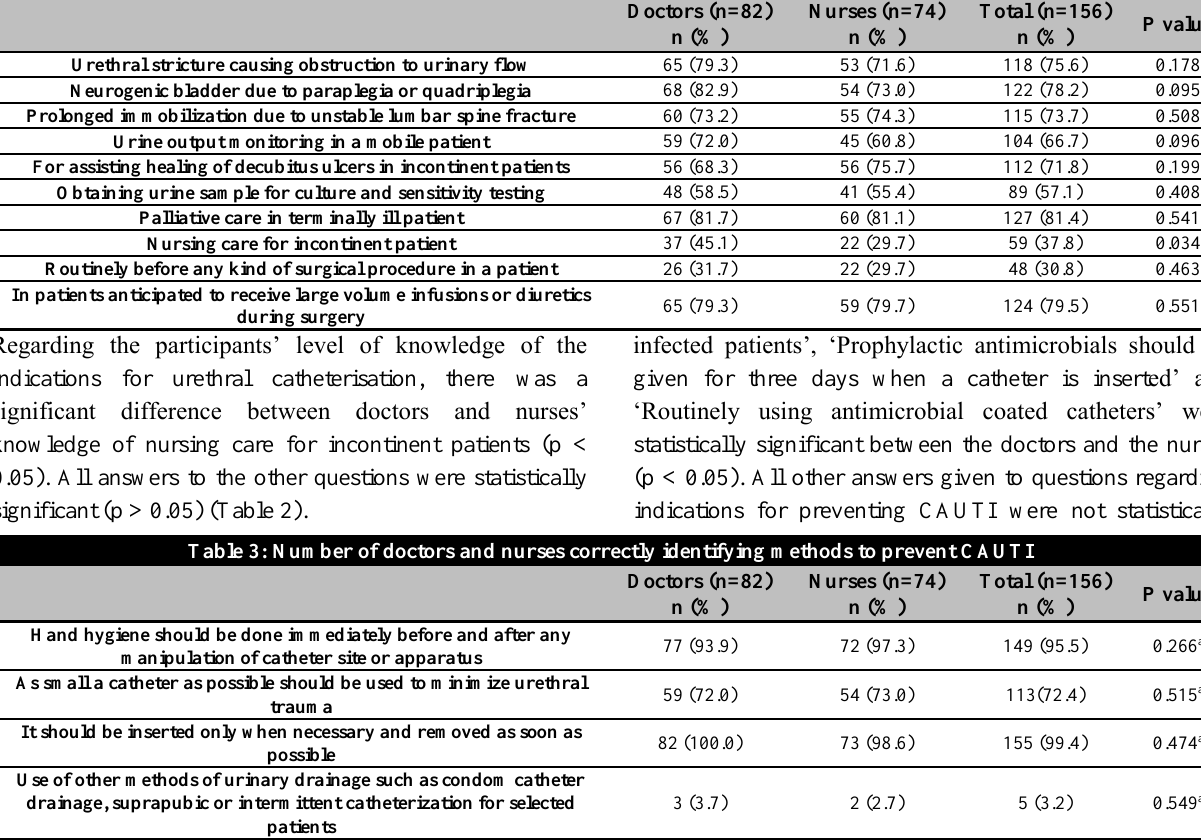
Table 2: Frequency of respondents having identified the indications correctly Doctors (n=82)